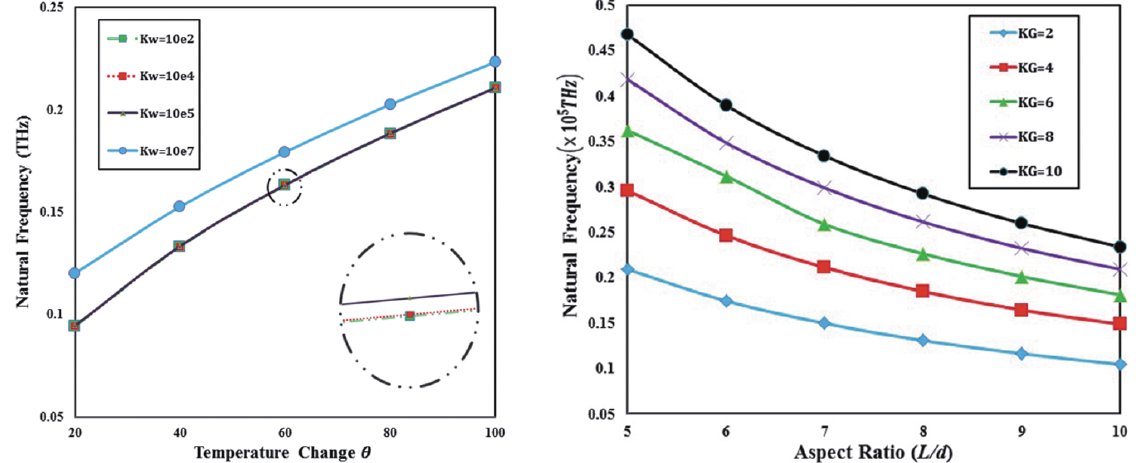
Fig. 11. Variation of natural frequency with temperature for different Winkler modulus K W . ( μ = 0 . 5 ,K G = 0 ,m = 1) .